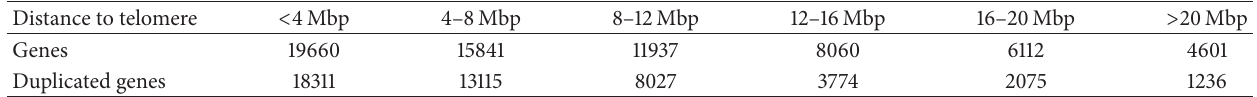
Table 1: Whole gene duplication and gene physical location.